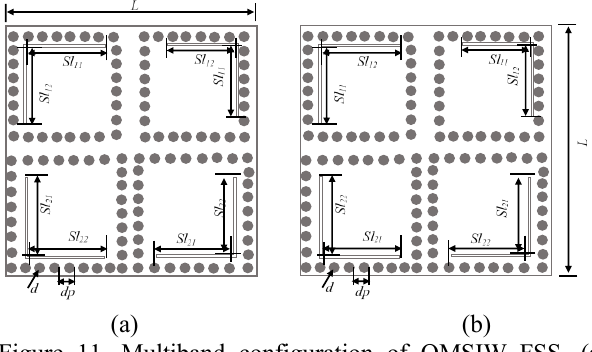
Figure 11. Multiband configuration of QMSIW–FSS. (a) Top layer. (b) Bottom